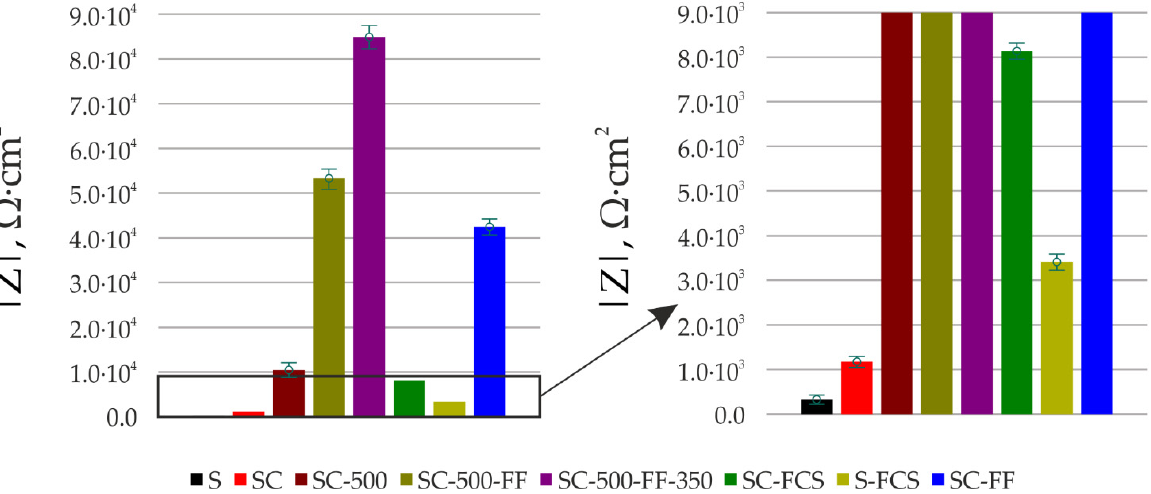
Figure 10. Evolution of impedance modulus measured at a frequency of 0.1 Hz for sample with different coatings.